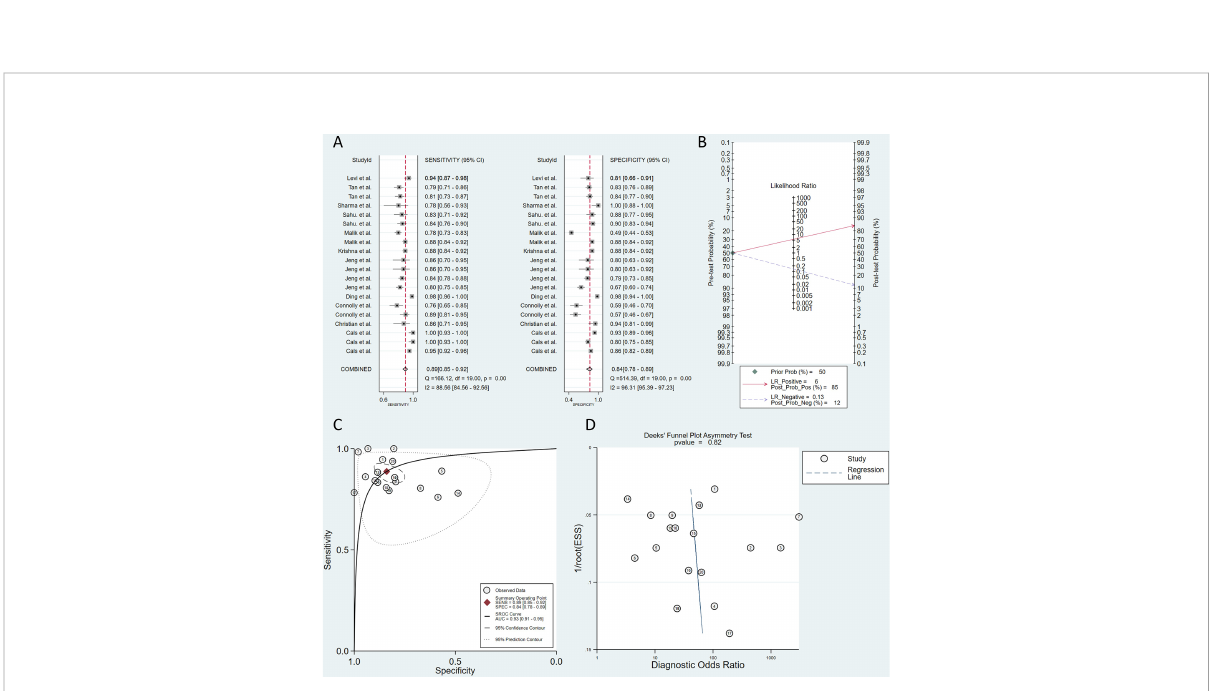
FIGURE 3 Plots of sensitivity and speci fi city (A) . The positive posterior probability (PPP) and negative posterior probability (NPP) (B) . Summary receiver operating characteristic (SROC) curve (C) . Deeks ’ funnel plot asymmetry test (D)